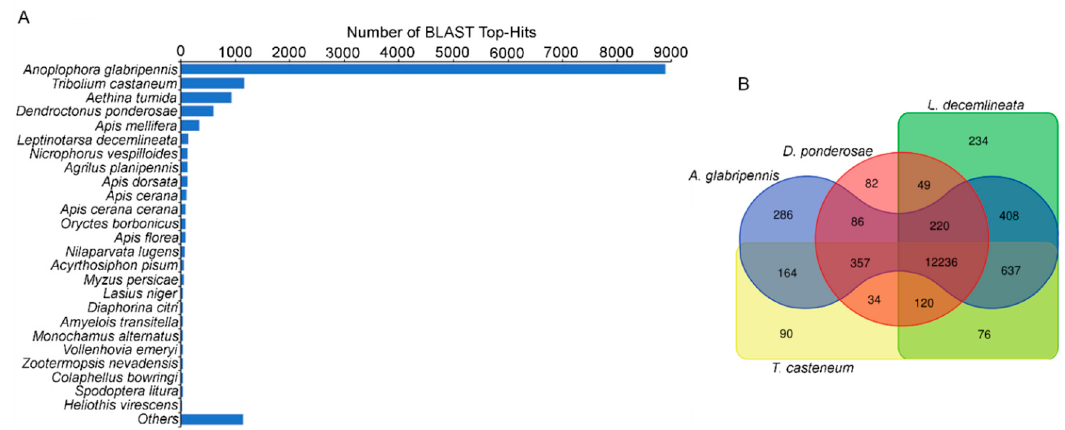
Figure 2. Homology analysis of the assembled unigenes. ( A ). BLAST Top-hits species taxonomic distribution. The graph shows the number of unigenes with BLASTX-Hits to the non-redundant (NR) NCBI database (E-value < 1 -10 ). ( B ). Edwards-Venn diagram shows the distribution of shared and unique BLASTX-Hits of the assembled unigenes of Z. subfasciatus compared with related species (E- value < 1 -5 ).